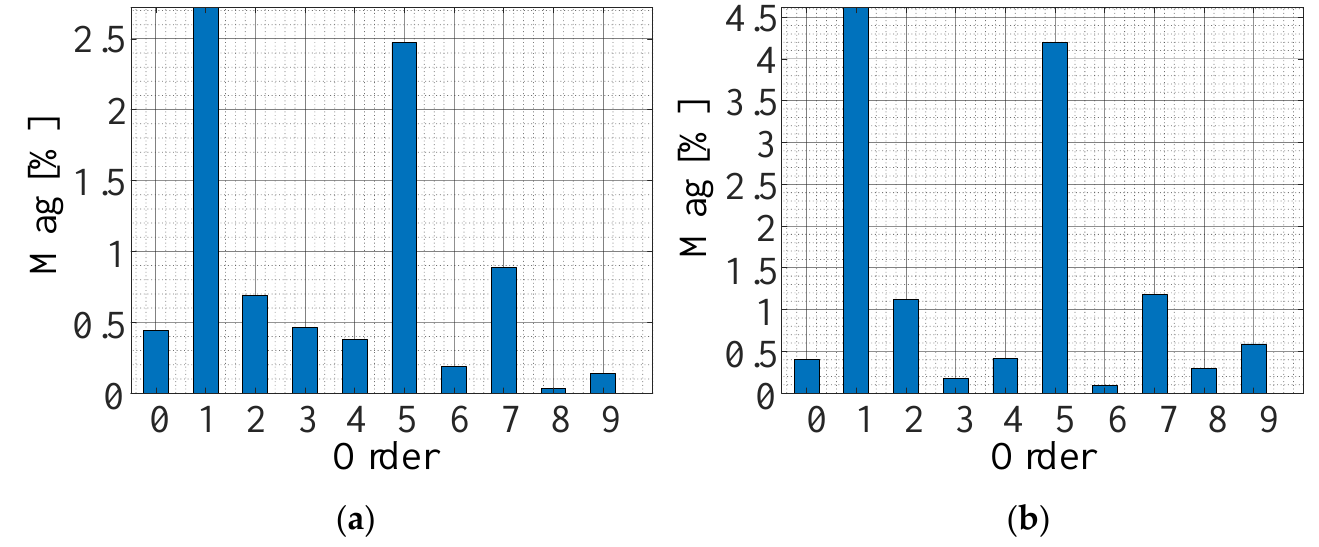
Figure 7. The lower order harmonics distribution of i as . ( a ) With deadtime; ( b ) with deadtime and conduction voltage drops. The sequence of the three-phase 5th harmonic is negative, the expressions of the 5th harmonic component of the three-phase stator current are defined as